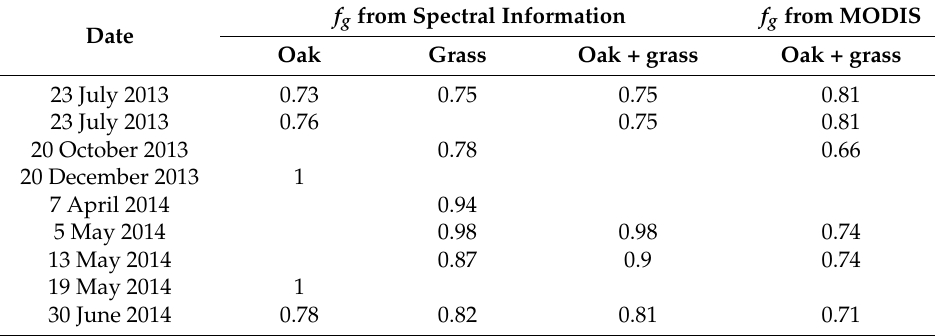
Table 2. f g estimated from in-situ spectra using MODIS bands functions and f g estimated from MODIS products for Santa